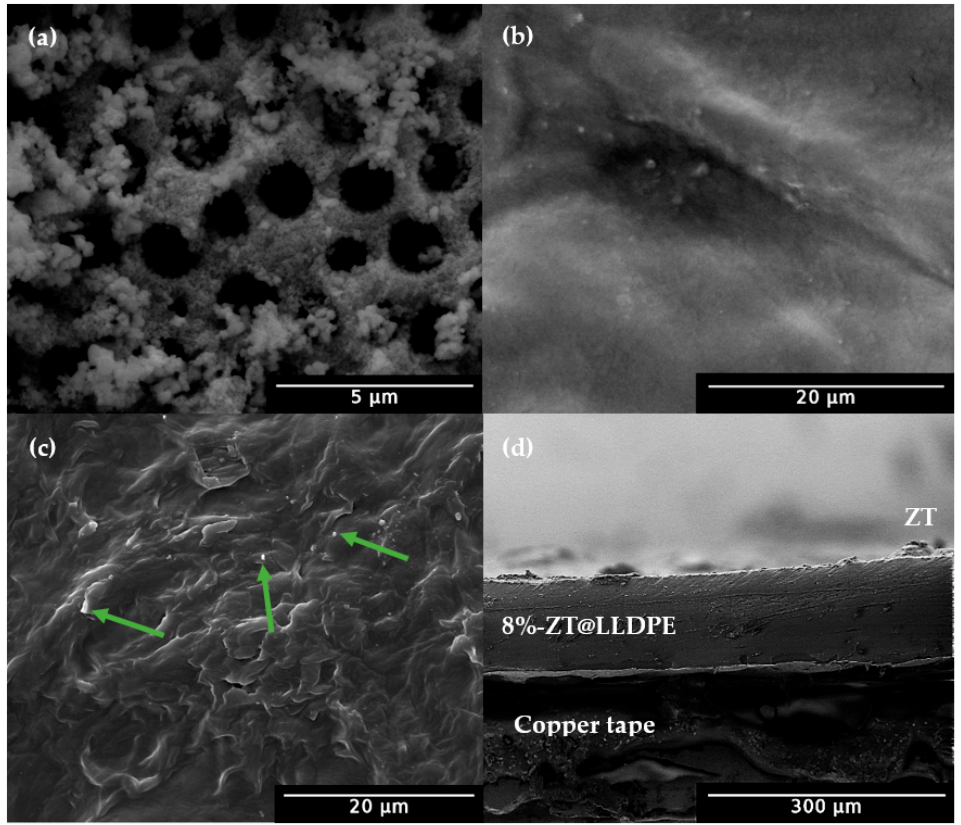
Figure 2. FESEM image of ( a ) ZT, ( b ) bare LLDPE, ( c ) 8%-ZT@LLDPE, and ( d ) cross-section of 8%-ZT@LLDPE. The green arrows indicate the ZnO QDs.